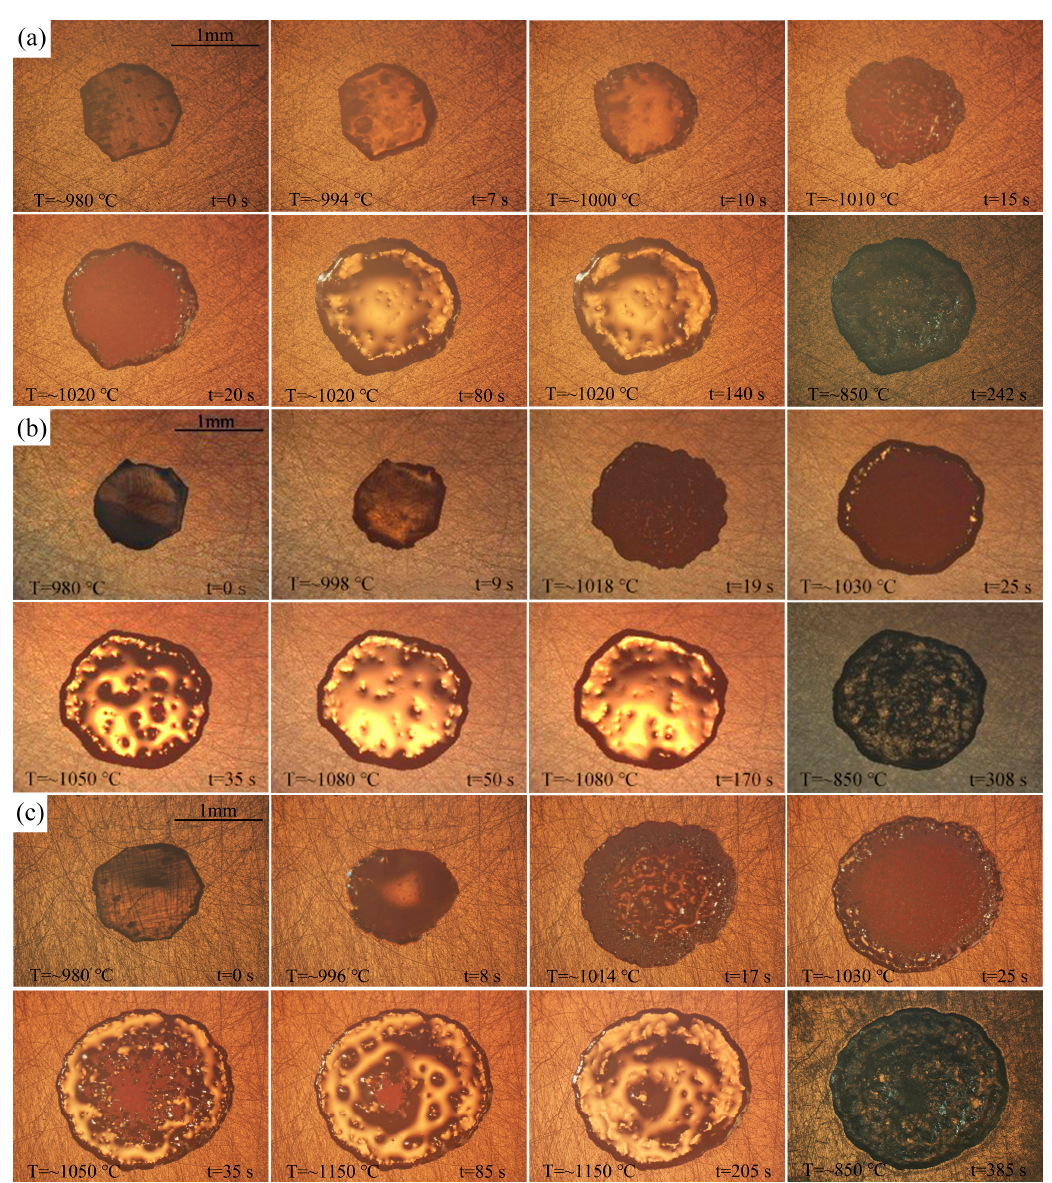
Figure 4. The representative instantaneous images of the wetting process of the BNi2 filler metals over the SLMed TC4 substrates at: ( a ) 1020 °C; ( b ) 1080 °C; and ( c ) 1150 °C. the SLMed TC4 substrates at: ( a ) 1020 ◦ C; ( b ) 1080 ◦ C; and ( c ) 1150 ◦